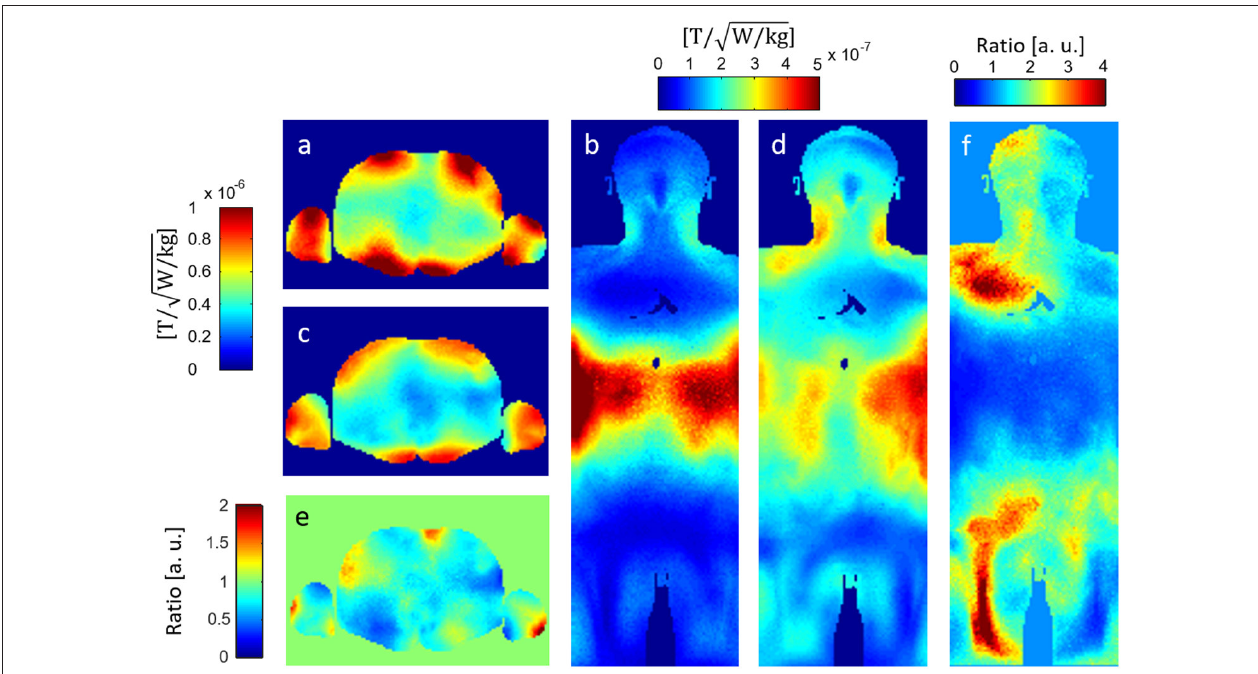
FIGURE 3 | Voxel-wise SAR efficiency of the two coils: (a,b) show the voxel-wise SAR efficiency for the local array, whereas (c,d) show the voxel-wise SAR efficiency for the integrated array; (e,f) show the ratio of the efficiency of the integrated array over the efficiency of the local array. The mean value in (e) is 0.83. The local array performs better in a region of approximately 25 cm along the magnet axis. Outside of this region it is outperformed by the integrated array.